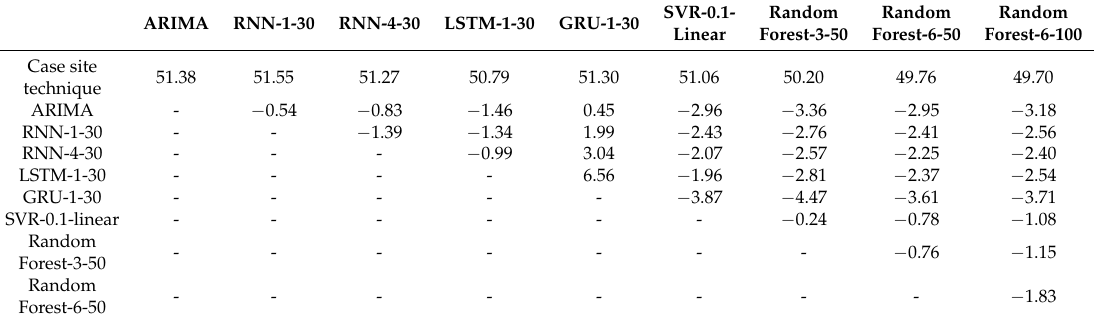
Table 5. Two-sample Diebold-Mariano test results for the deep-learning and machine-learning models and the manual and ARIMA